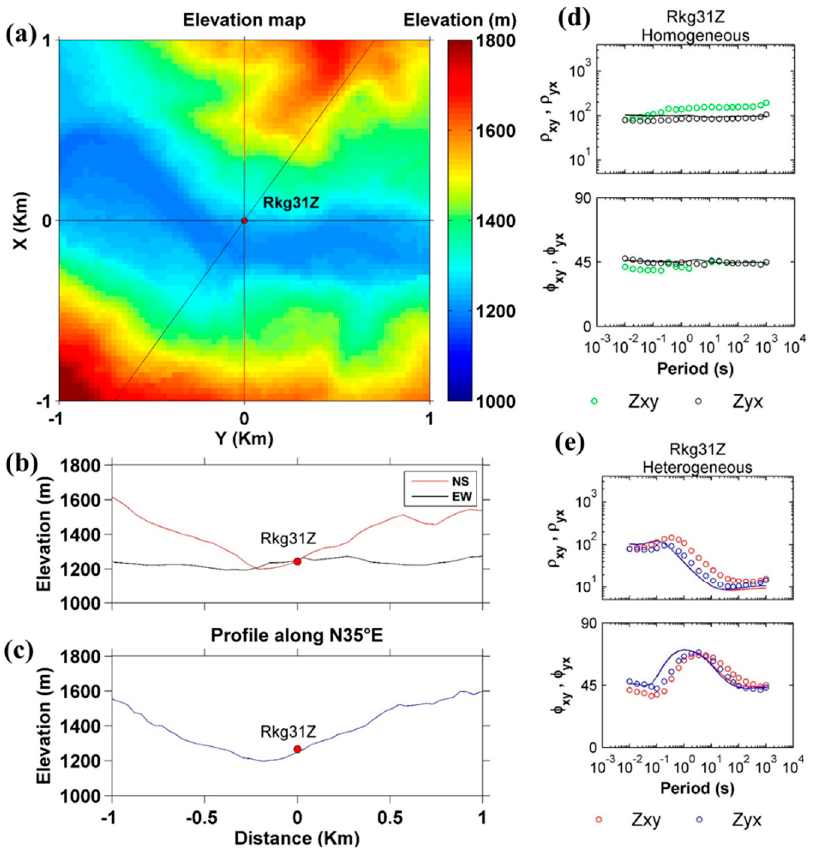
Figure 11. ( a ) The elevation map around site 31. ( b ) Elevation profile along the NS, EW and the direction of maximum elevation change ( c ). ( d ) The comparison of MT response of off-diagonal components generated by ( d ) homogeneous half-space model and ( e ) heterogeneous model.